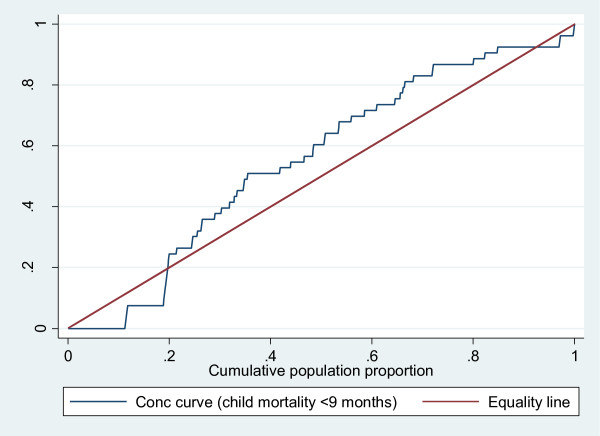
Concentration curve for child mortality <9 months.